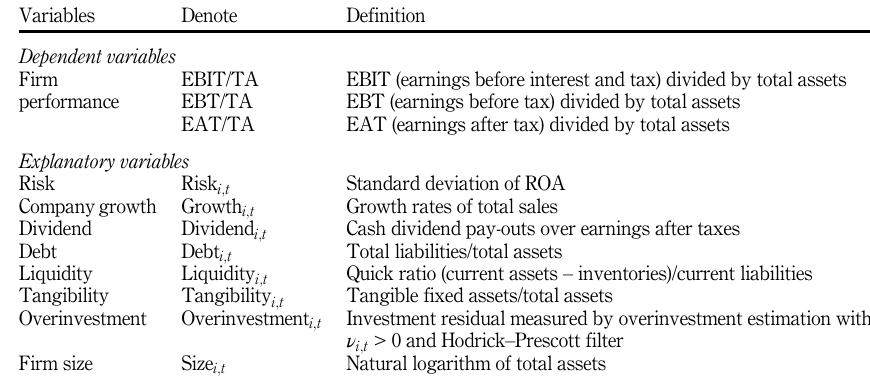
Table A1. Variable measurements